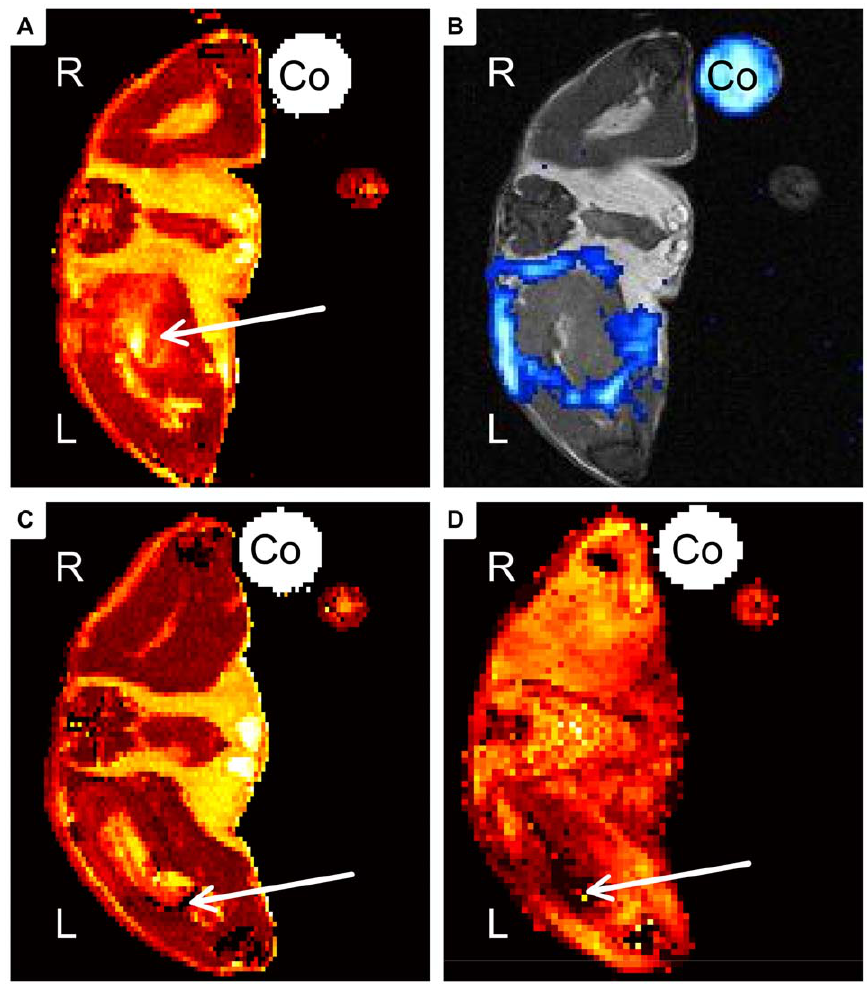
Figure 1. Representative MR Images of acute soft-tissue infection. A, B) Mouse received PFC at day 2 post infection. Images were recorded 24 h after administration. C, D) Mouse received CLIO at day 2 post infection and was imaged 24 h after administration. A) Transverse T 2 map of PFC group mouse shows hyperintensity within infected muscle (arrow). B) 19 F-SSFP CSI overlay on 1 H-TSE image of PFC treated mouse shows strong accumulation of PFC at the rim of abscess area. C) Transverse T 2 map of CLIO group mouse shows hyper-intense area diffusely circumscribed by dark spots (arrow). D) T 2 * weighted image shows diffusely distributed susceptibility effects in the infected muscle (arrow). (Co: Control tube filled with PFC dilution, R: right side, L: left side of the imaged mouse).